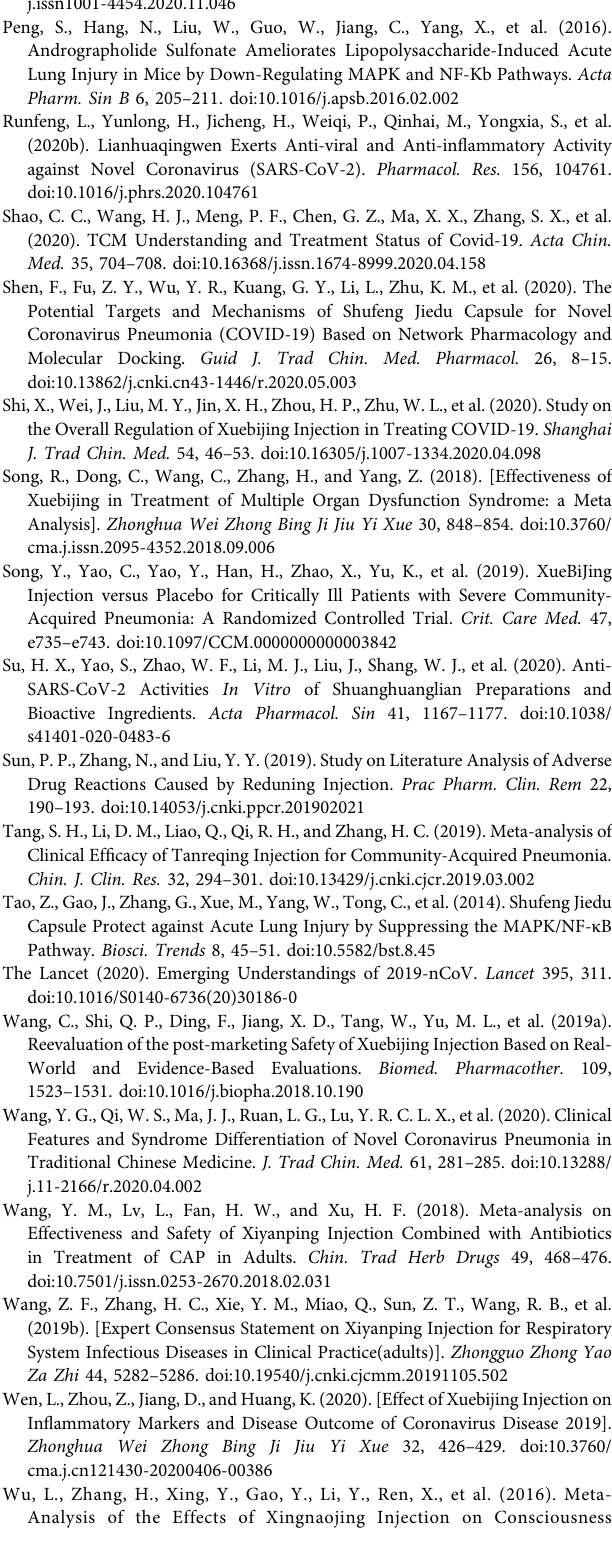
Protocol for a Randomized Controlled Trial. Trials 18, 479. doi:10.1186/